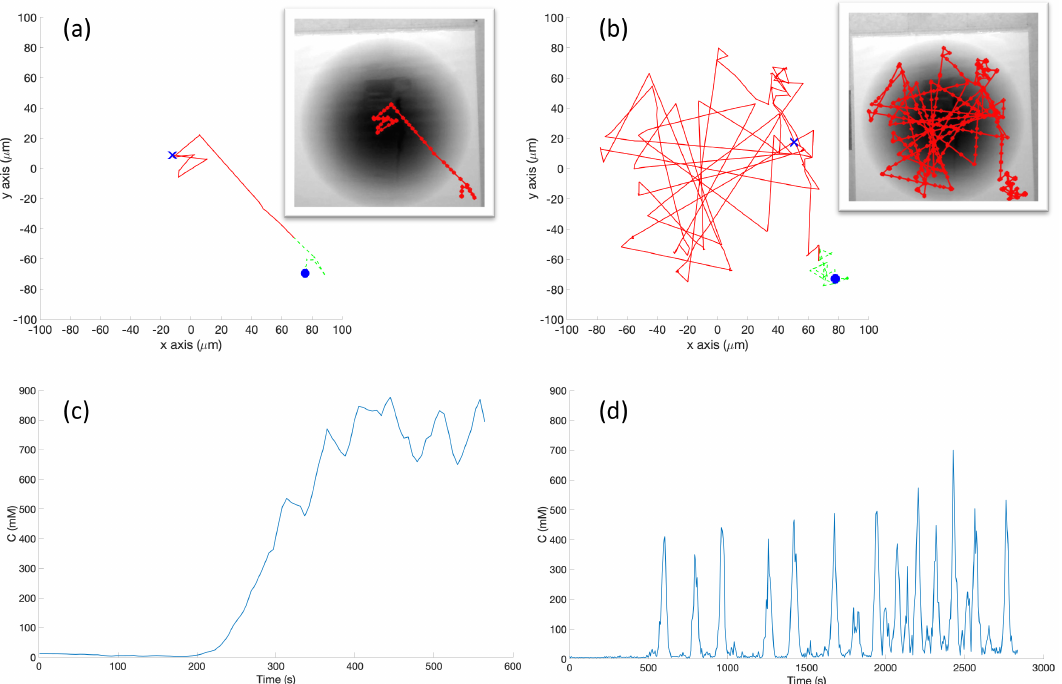
Figure 14. Case 5: Without obstacles, in the single-effluent environment, typical trajectories of the e-puck robot running ( a ) the basic chemotaxis controller, and ( b ) the RapidCell chemotaxis controller. In each trajectory, the initial position is shown as a blue circle and the terminal position is shown as a blue “X”. Positions corresponding to concentrations less than 1m M are shown in dashed green, otherwise shown in red. The recorded concentrations associated with each scheme are shown in ( c , d )